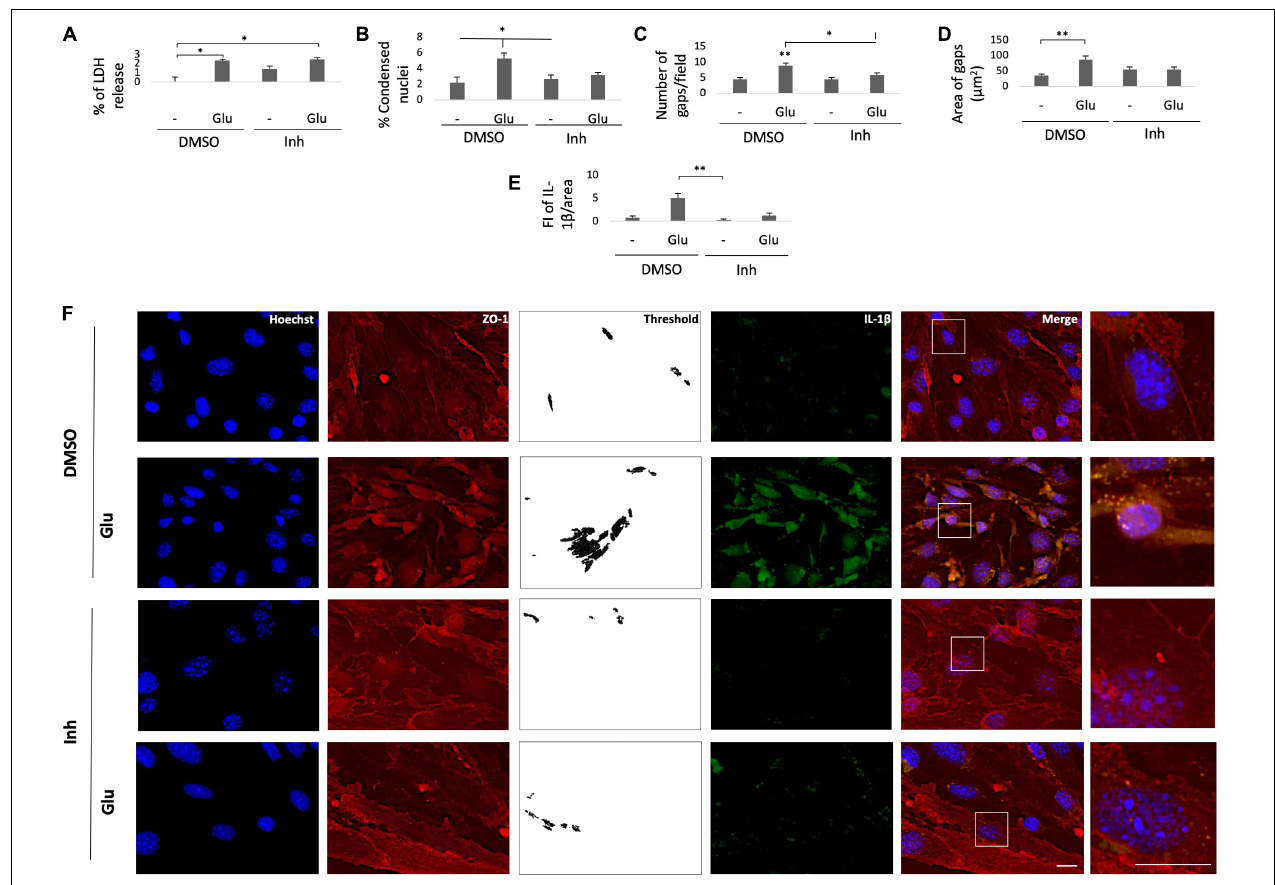
FIGURE 7 | BACE1-inhibited astrocytes protect the integrity of cocultured ECs from damage caused by glutamate. (A) Percentage of LDH release by the astrocyte-endothelium coculture after different treatments. (B) Percentage of condensed nuclei for each treatment, quantified from 20 fields per treatment for each n. (C) The number of gaps per field from threshold images. (D) The area of gaps between cells expressed in µ m 2 , quantified as the mean of the black area in threshold images from 20 fields per treatment for each n. (E) FI of IL-1 β per unit area, quantified from 20 cells per treatment for each n and divided by unit area. All data just described are presented as the means ± SEM of n = 4. (F) Morphological characterization of endothelial cells that were cocultured with primary astrocytes showing nuclei stained with Hoechst (blue), IL-1 β visualized with Alexa Fluor 488 (green) and the tight junction protein ZO-1 visualized with Alexa Fluor 594 (red). Magnification: 60x. Scale bar: 20 µ m. The zoomed insets show the condition of the nuclei and the distributions of ZO-1 and IL-1 β . DMSO = vehicle, Inh = β -secretase inhibitor IV, - or Glu refers to glutamate treatment. All experiments were performed in duplicate. (A–D) ANOVA followed by Tukey’s test and (E) Kruskal-Wallis test followed by Dunn’s test with Bonferroni correction. * P < 0.05, ** P <